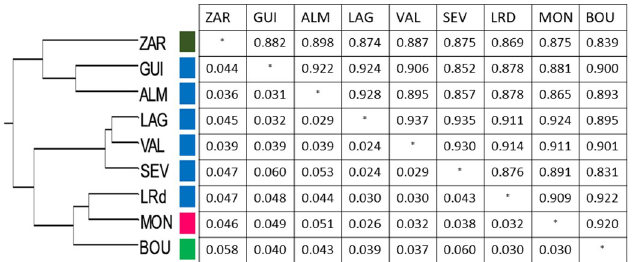
Fig 2. UPGMA dendrogram of the different sampled populations based on Nei’s unbiased genetic distance; the color codes correspond to cluster colors on Fig 1. The associated table shows Nei’s genetic identity values (upper diagonal) and pairwise population FST values (below diagonal).